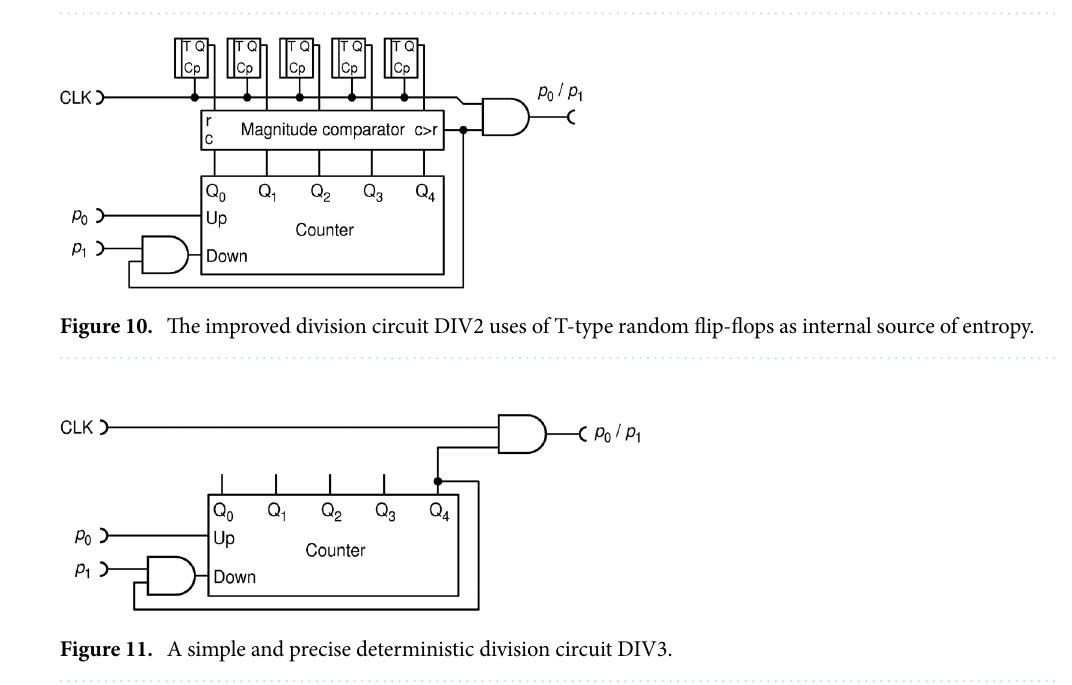
Figure 9. Transfer functions (a) ; and errors from the ideal division calculation (b) , for the circuit DIV1, shown in Fig. 8b. N is the counter capacity in bits.